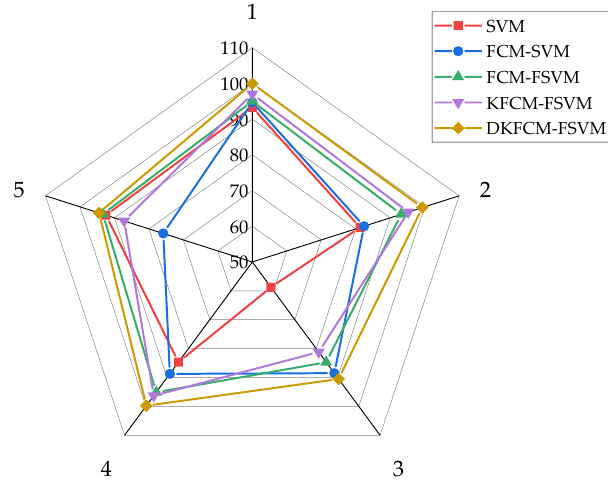
Figure 7. The accuracy of the wireless sensor network algorithm models. The comparison results of the false positive rate between the DKFCM-FSVM and the comparison calculations are shown in Figure 8. Compared with the control calculations, the DKFCM-FSVM’s false positive rates when identifying the five behaviors were 0.005, 0.004, 0.01, 0.003, and 0.006 respectively. It achieved the minimum false positive rate when identifying different behaviors. The false positive rate reflects the proportion of normal behaviors recognized as abnormal behaviors. This was because the FSVM used the fuzzy membership obtained from the DKFCM as the fuzzy factor, which enhanced the objectivity of the selection of the fuzzy factors and improved the classification accuracy, thus improving the effect of the intrusion detection in the WSN scenarios.